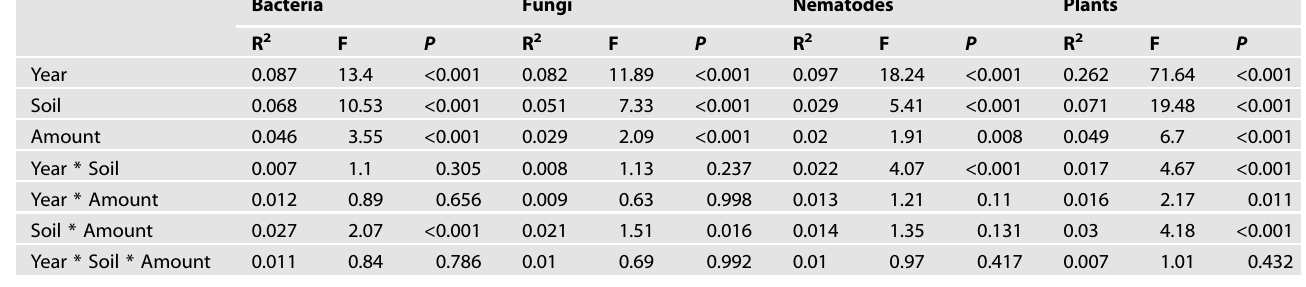
Table 1. Effects of year, soil type, inoculum amount and their interactions on soil and plant communities (Adonis test).